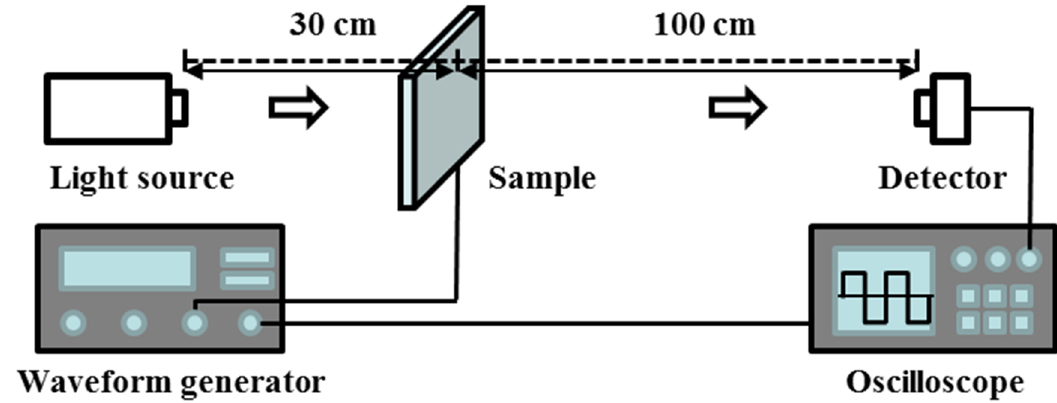
Figure 7. Schematic diagram of the experimental setup for measuring the voltage–transmittance (V–T) curves and response time. Using a waveform generator, voltages from 0 V to 110 V are applied and then the waveform and transmittance are observed simultaneously. A halogen lamp is used as the light source.